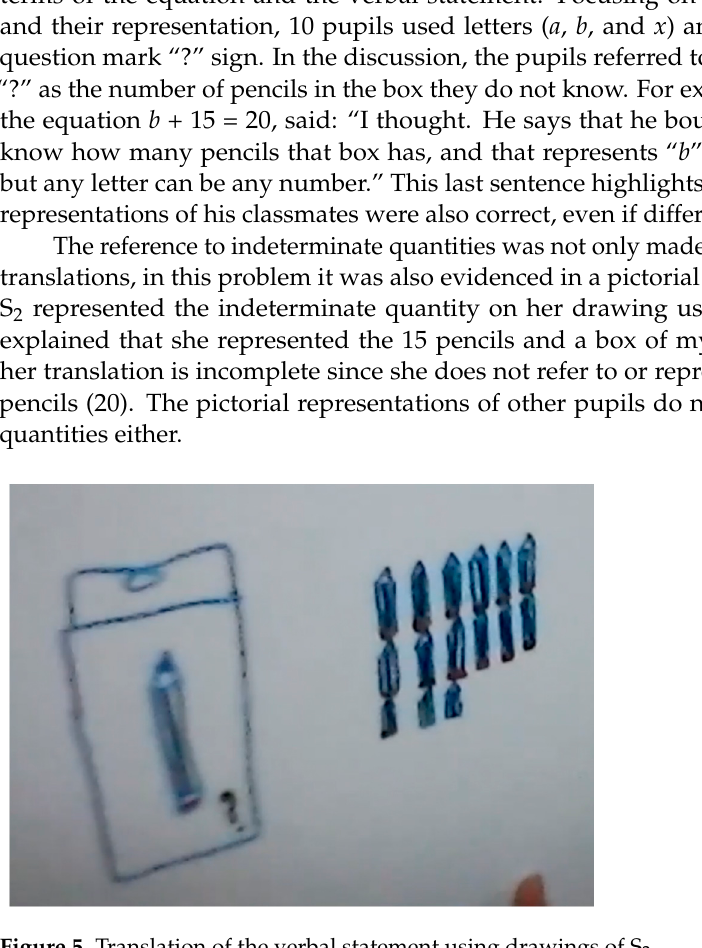
Figure 5. Translation of the verbal statement using drawings of S 2 .